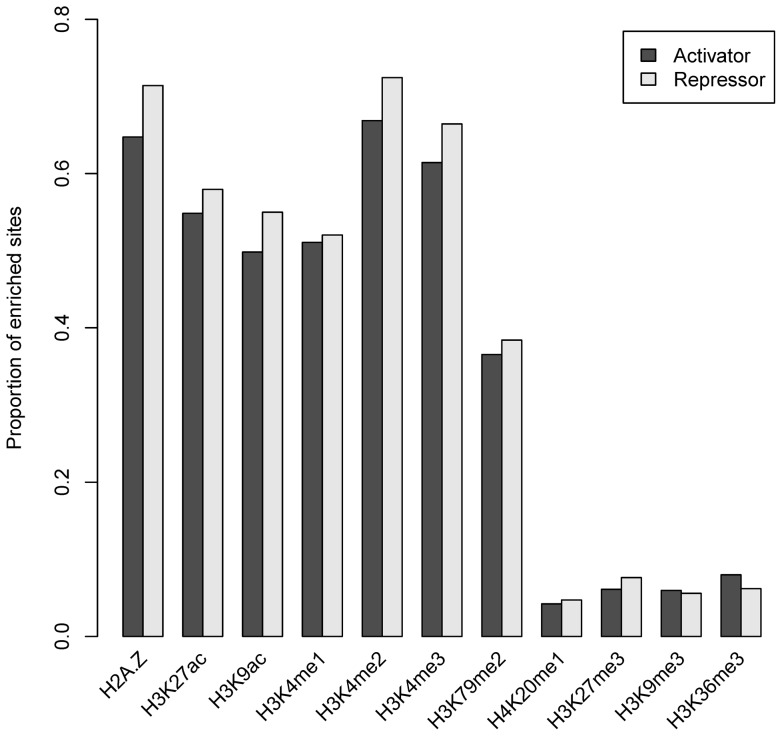
Enrichment of CENTIPEDE activator and repressor sites in a 600-bp window.Most marks showed a slight difference in enrichment percentage between activator and repressor sites.